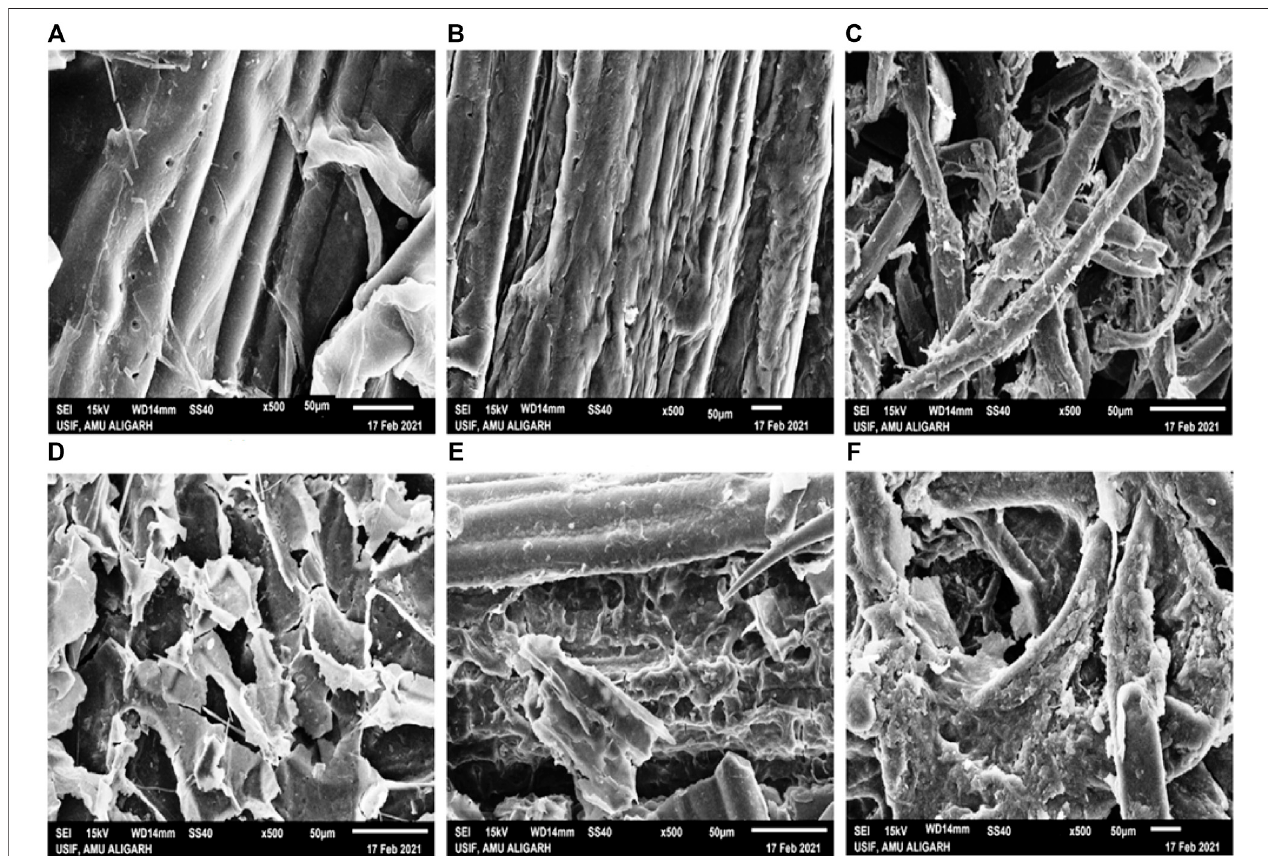
FIGURE 7 | Scanning electron microscopy (SEM) of untreated biomass, SCB, WS, and FP (A – C) , and biomass residues, SCB, WS, and FP (D – F) treated with B. subtilis CD001 cellulase respectively.